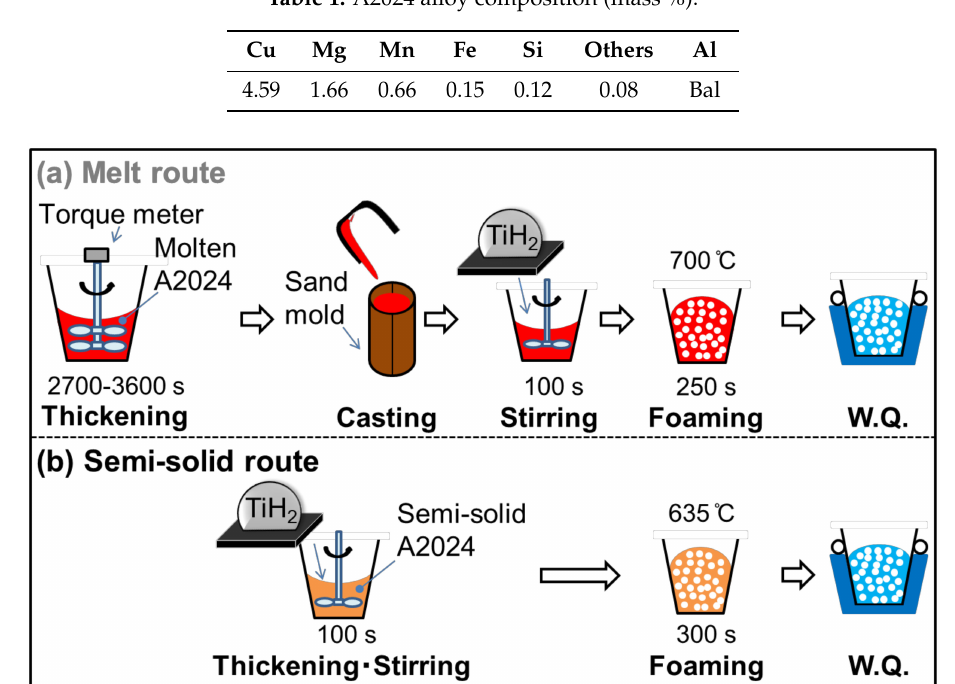
Figure 1. Fabrication methods of A2024 foam: ( a ) melt route; ( b ) semi-solid